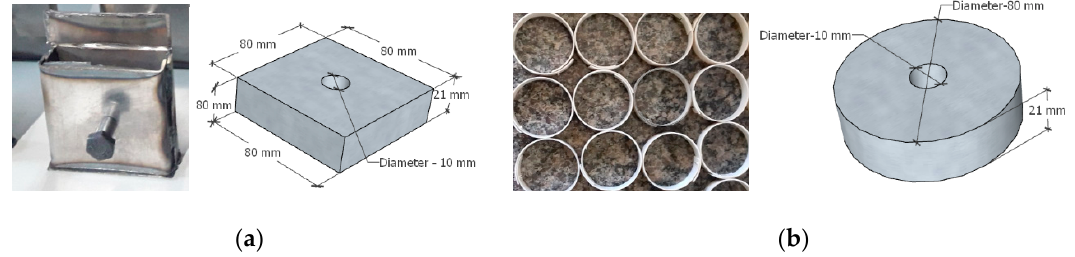
Figure 15. Shape of the spacers used in the space truss. ( a ) Shape of the cold-formed steel with 1.5 mm thickness for encapsulating of the concrete with steel fiber, ( b ) Polyvinyl Chloride (PVC) molds for spacers with concrete with steel fiber without the encapsulation of concrete.